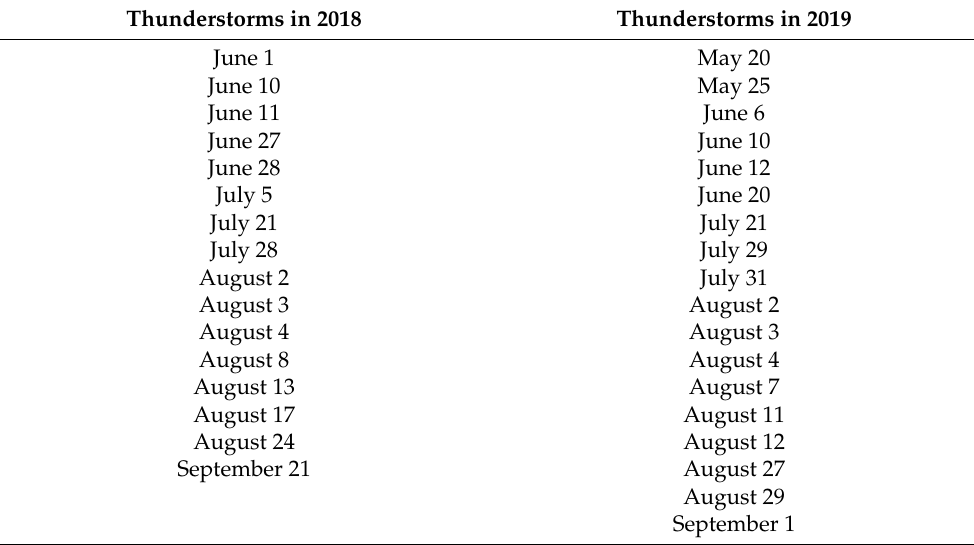
Table 2. Thunderstorms of 2018 ( left panel ) and 2019 ( right panel ) with lightning discharges registered 0–20 km from the Milešovka